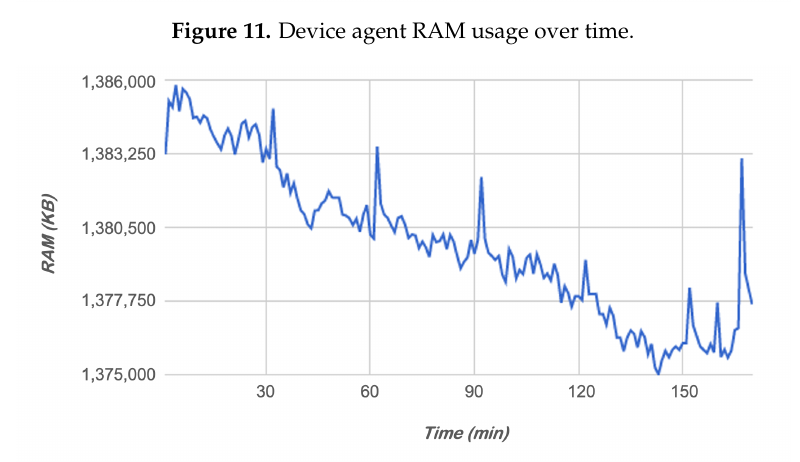
Figure 12. System RAM usage over time.